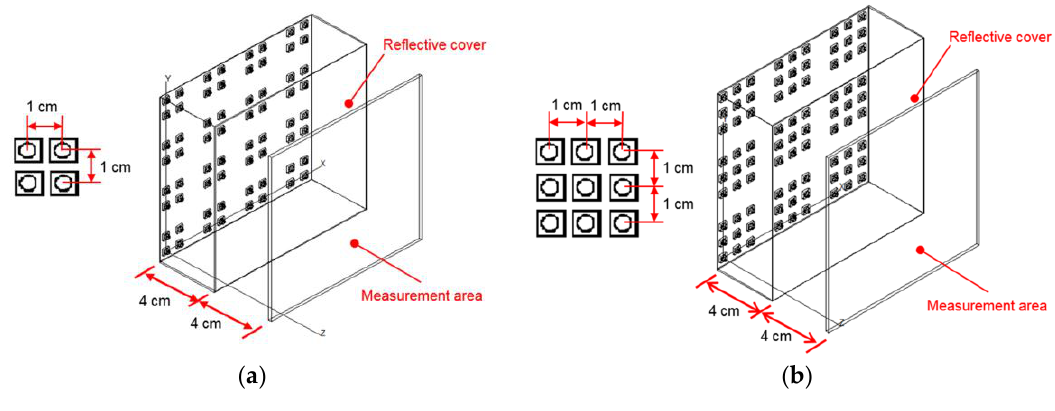
Figure 5. Simulation model: ( a ) type A, ( b ) type B.